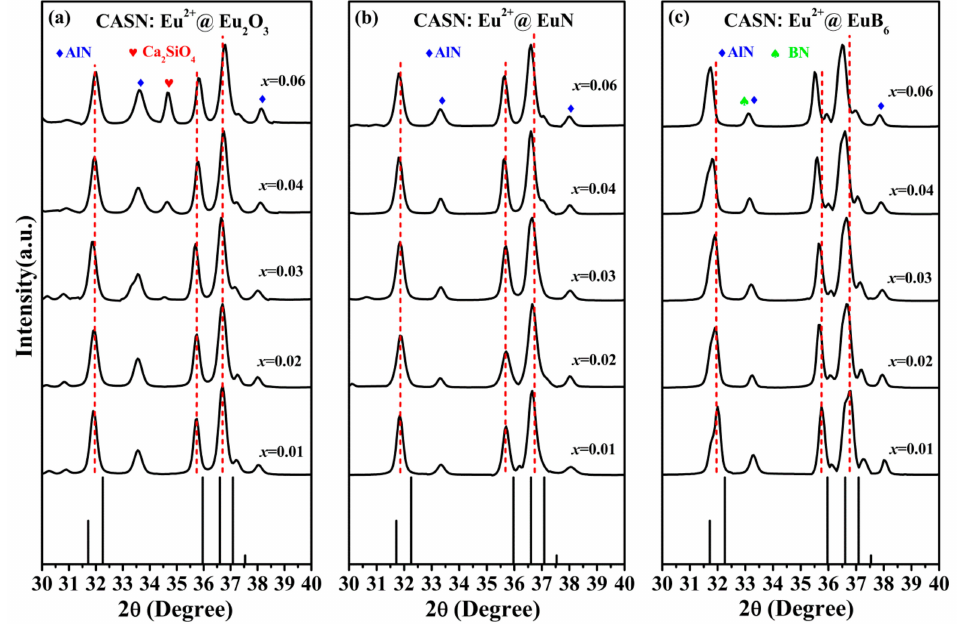
Figure 3. The major XRD patterns of three nitride red phosphors in the range of 30–40 ◦ ; ( a ) CASN:Eu 2+ @Eu 2 O 3 ; ( b ) CASN:Eu 2+ @EuN and ( c ) CASN:Eu 2+ @EuB 6